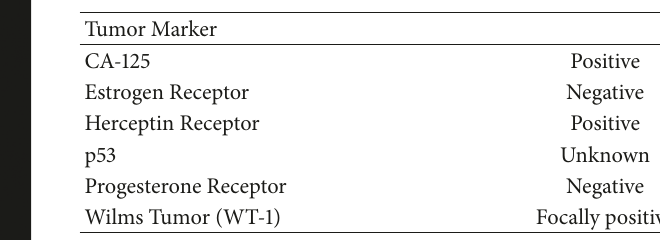
Table 1: Pertinent tumor marker results of recurrent paravaginal cyst